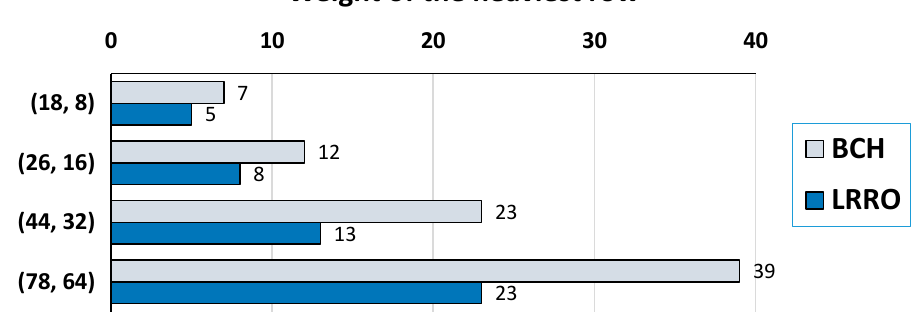
Figure 3. Hamming weights of the heaviest row.